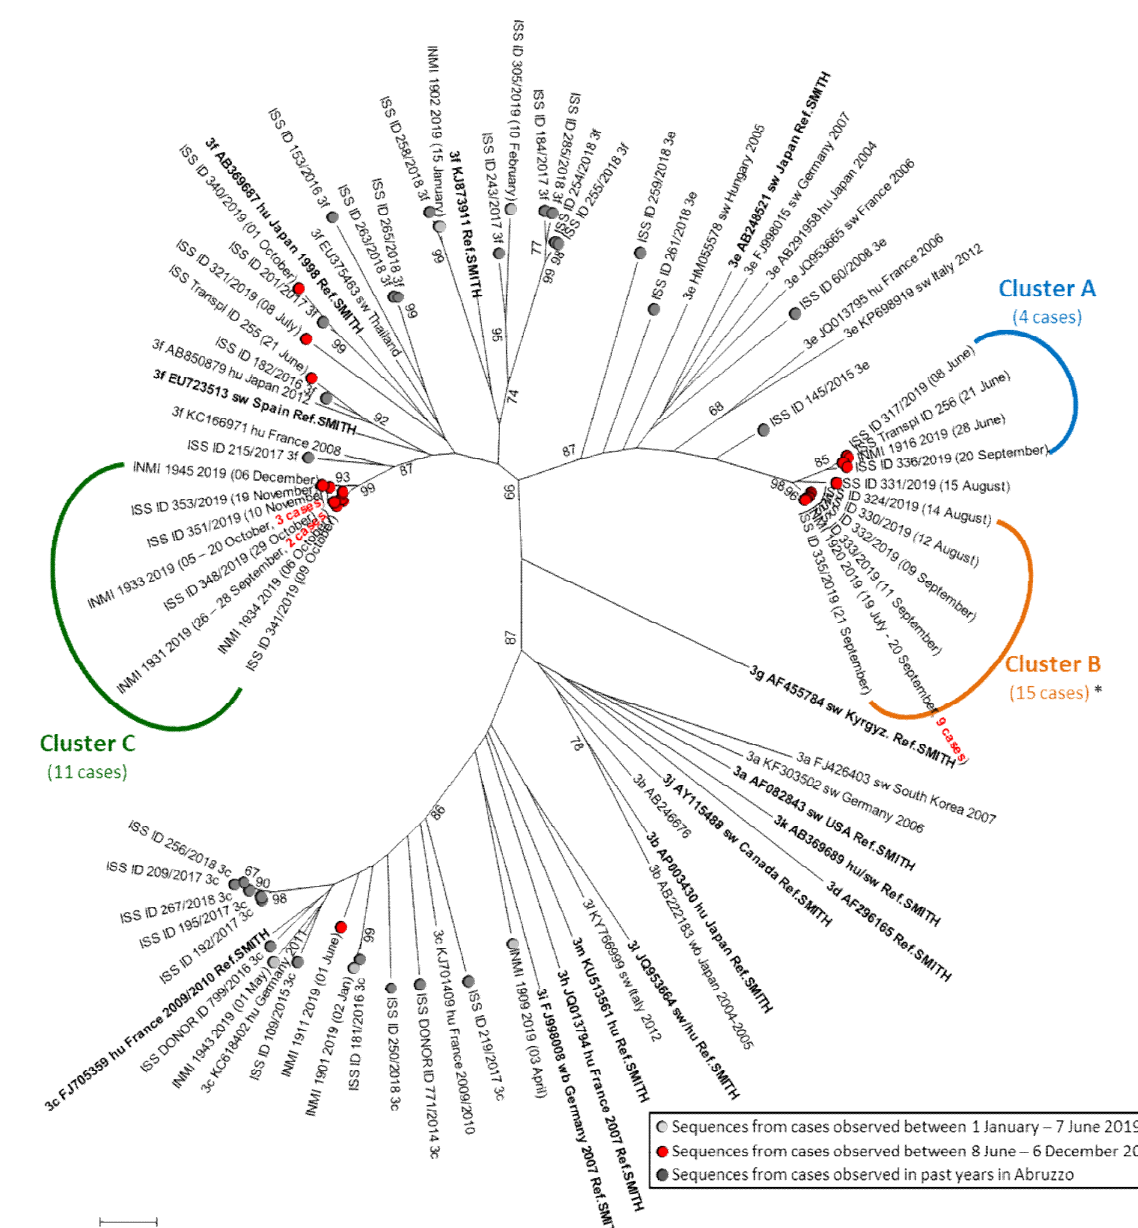
Figure 1. Phylogenetic tree of the HEV sequences. A red circle marks the HEV sequences obtained between 8 June and 6 December 2019 (including both sporadic and outbreak cases). Sequences from Abruzzo: the sequence label begins with “ISS”; sequences from Lazio: the sequence label begins with “INMI”. Some sequences are representative of a group of identical sequences (the overall number of represented cases is reported in bold red in the sequence label). A dark gray circle marks the HEV sequences obtained in Abruzzo in the years before 2019 and a light gray circle marks HEV sequences from cases with onset between 1 January and 7 June 2019. Reference genotype 3 strains with known subtype were included in the analysis (in bold: references proposed in [29] and/or [30]); subtype, accession number, host (hu: human; sw: swine, wb: wild boar; de: deer; mo: mongoose; ra: rabbit), and year of detection are reported for each reference sequence whenever available. Bootstrap values > 65 are shown. *: the 15 cases of Cluster B include a case for which a very short sequence could not be included in the phylogenetic analysis; however, it showed 100% identity with the sequences in Cluster B over the entire available length, 165